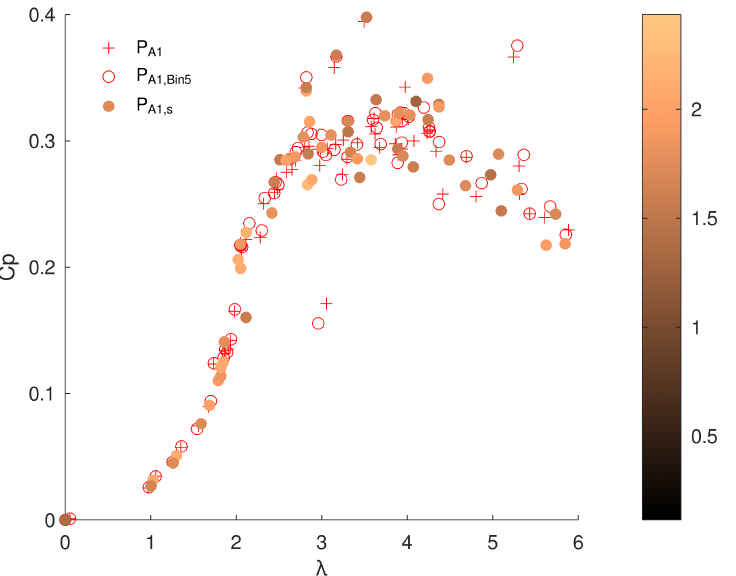
Figure 16. C p – λ data based on raw DA A1 data vs selected bin 5 vs steady 30 s section according to Vector 1. Colour indicates rms (Ux,steady across bins) Comparison with Tank and Numerical